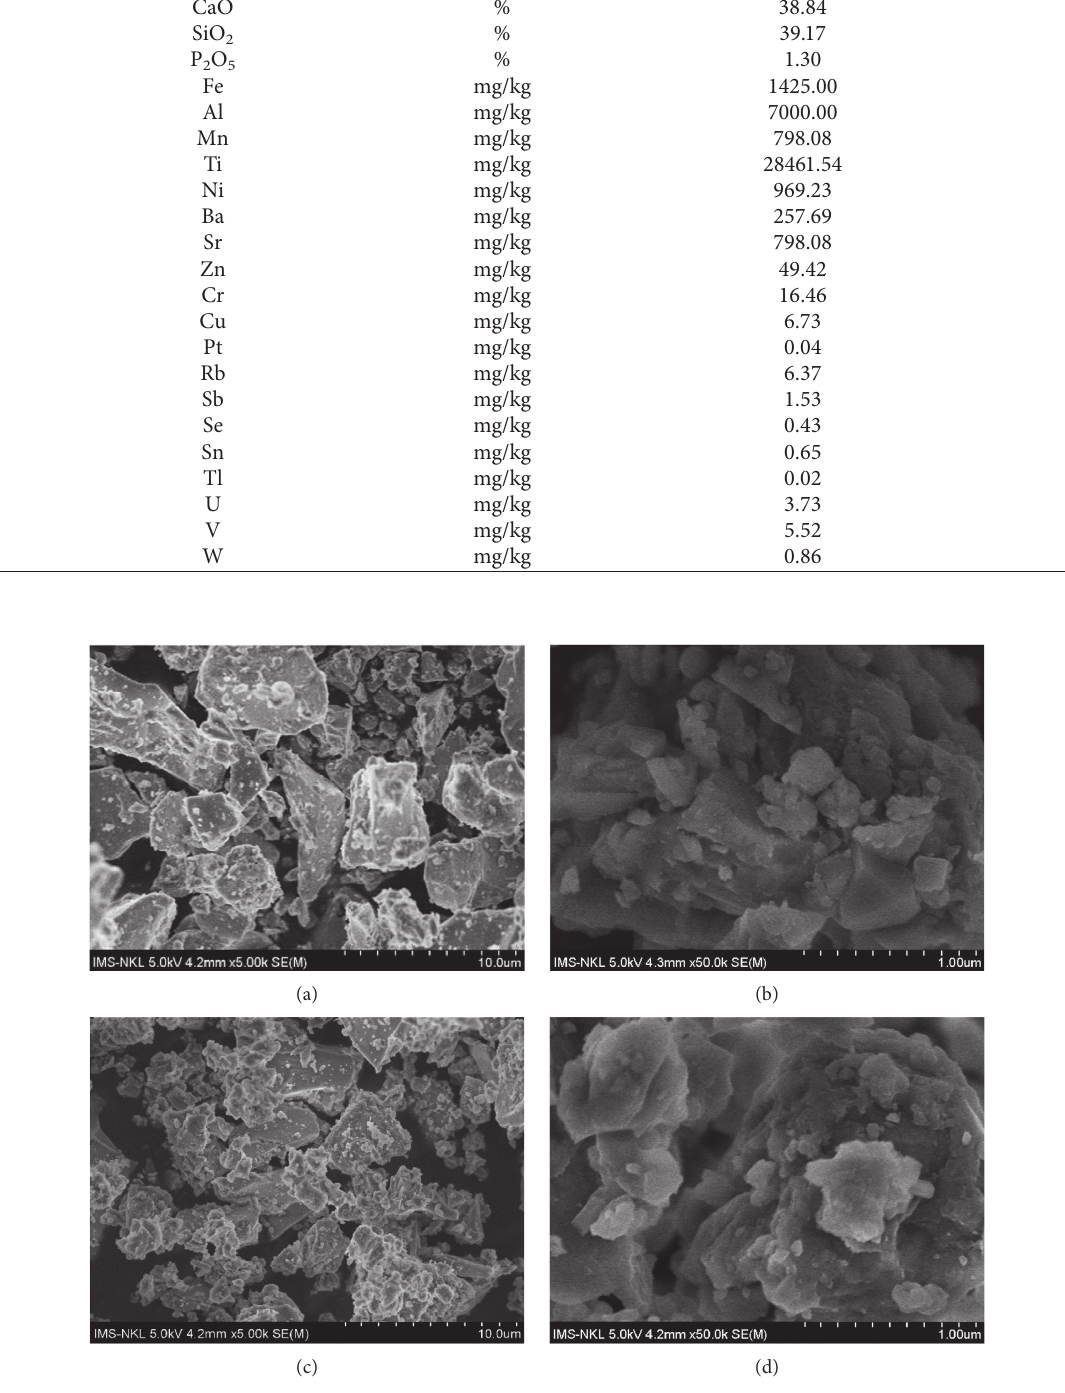
Figure 6: FESEM images of YPS samples at magnification of 5000 times and 50000 times. YPS1 (a, b); YPS2 (c,